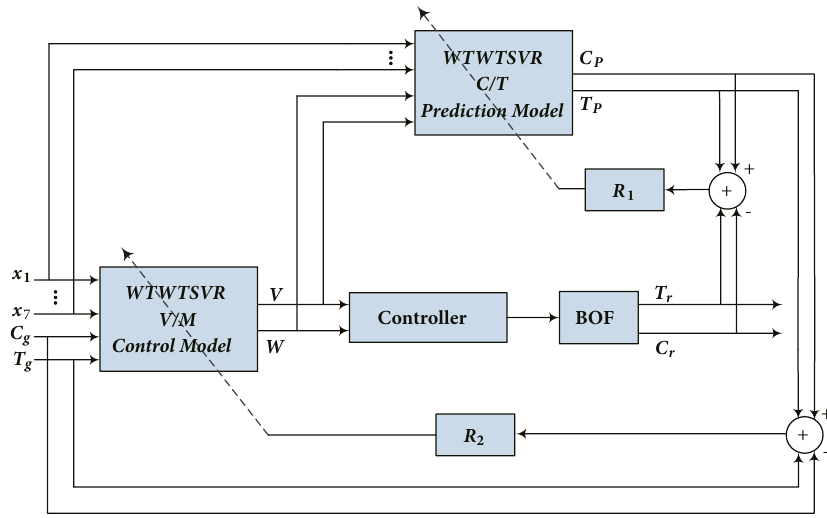
Figure 3: Structure of proposed BOF control